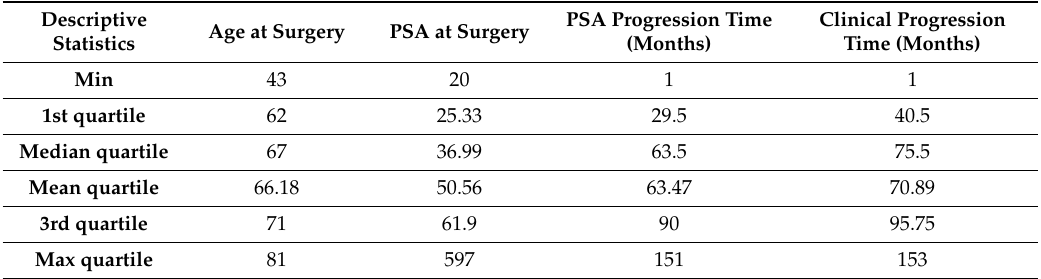
Table 1. Clinical parameters of the EMPaCT TMA patient cases.